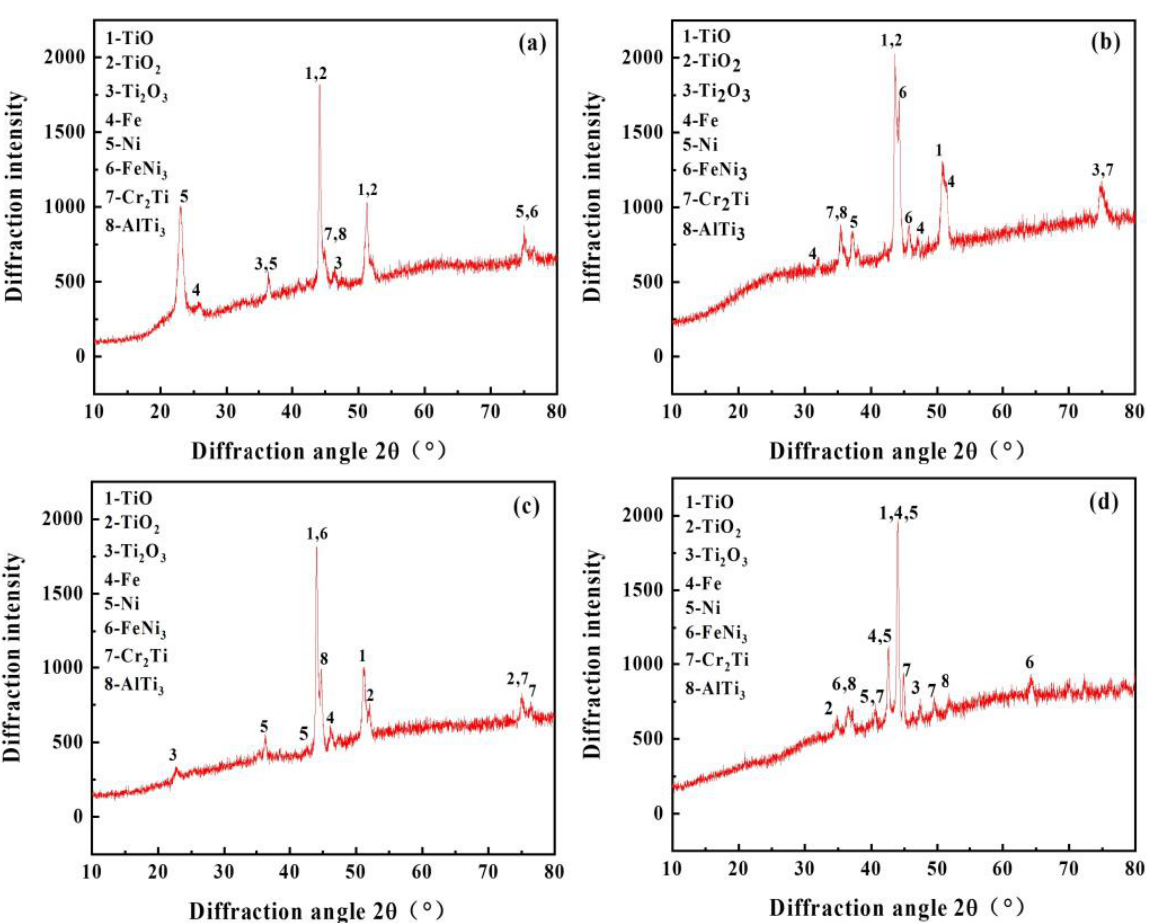
Figure 16. Analysis of phase composition of LCC specimen with various Ni60/TC4 mass ratios ( a ) No. 1 (pure TC4); ( b ) No. 2 (2/8); ( c ) No. 3 (3/7); ( d ) No. 4 (4/6).